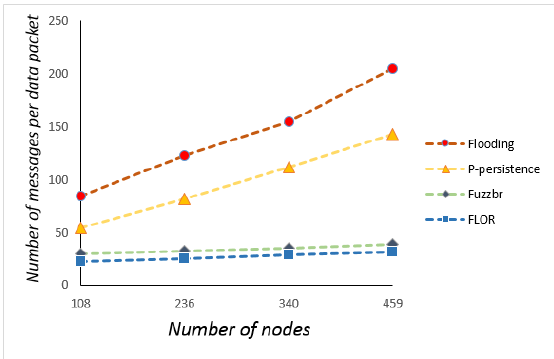
Figure 10. Number of messages per data packet for various numbers of